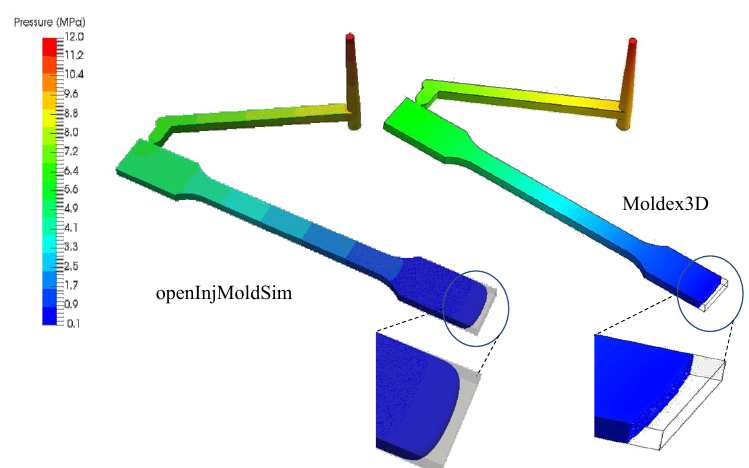
Figure 10. Pressure distribution at the switch-over point and melt flow front shape predicted by the most refined mesh of both software.